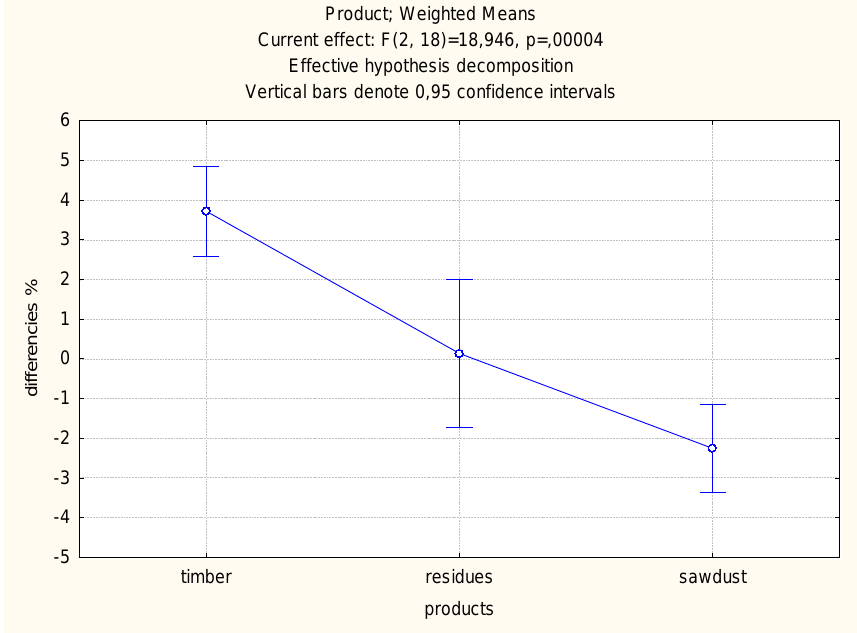
Figure 17. Average values of the differences in the measured and calculated values for the products.